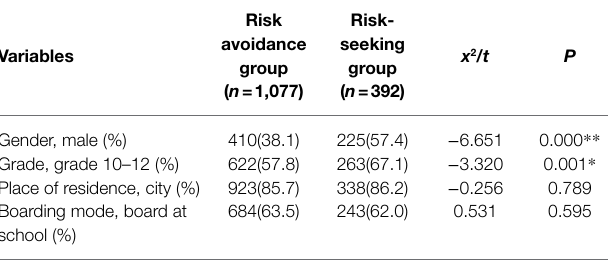
TABLE 9 | Univariate comparison of independent variables between the risk avoidance and risk-seeking groups ( n = 1,469).